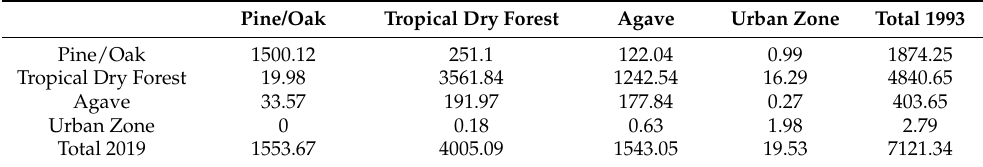
Table 4. LULC transition matrix 1993–2019 (ha).